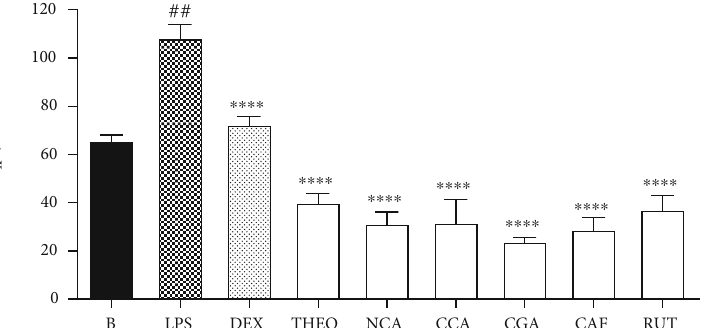
Figure 7: E ff ects of chemical marker compounds on NOx secretion levels in LPS-treated RAW 264.7 macrophages. B: untreated cells; LPS: cells treated with only lipopolysaccharide (1 μ g/mL); DEX: cells pretreated with dexamethasone (7 μ M) before LPS administration. Results were expressed as mean ± SEM ; n = 3 ; ## p < 0 : 0001 vs. group LPS; ∗∗∗∗ p < 0 : 01 vs. group B. THEO: theobromine; NCA: neochlorogenic acid; CCA: cryptochlorogenic acid; CGA: chlorogenic acid; CAF: ca ff eine; RUT: